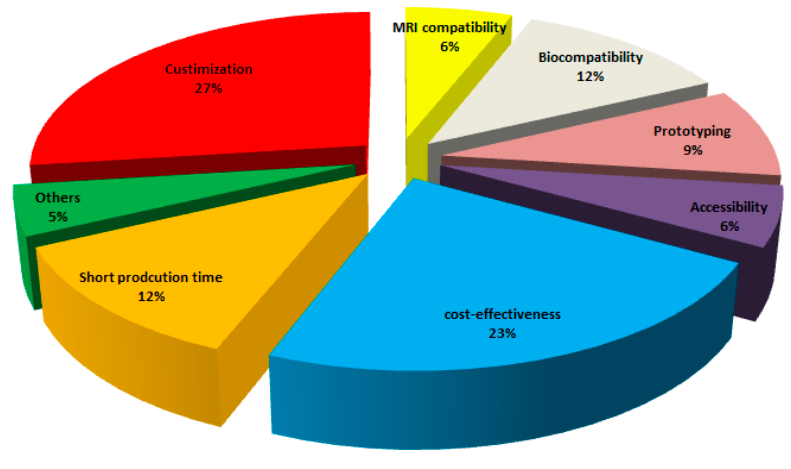
Figure 6. Reasons for the choice of AM in medical fields [27].